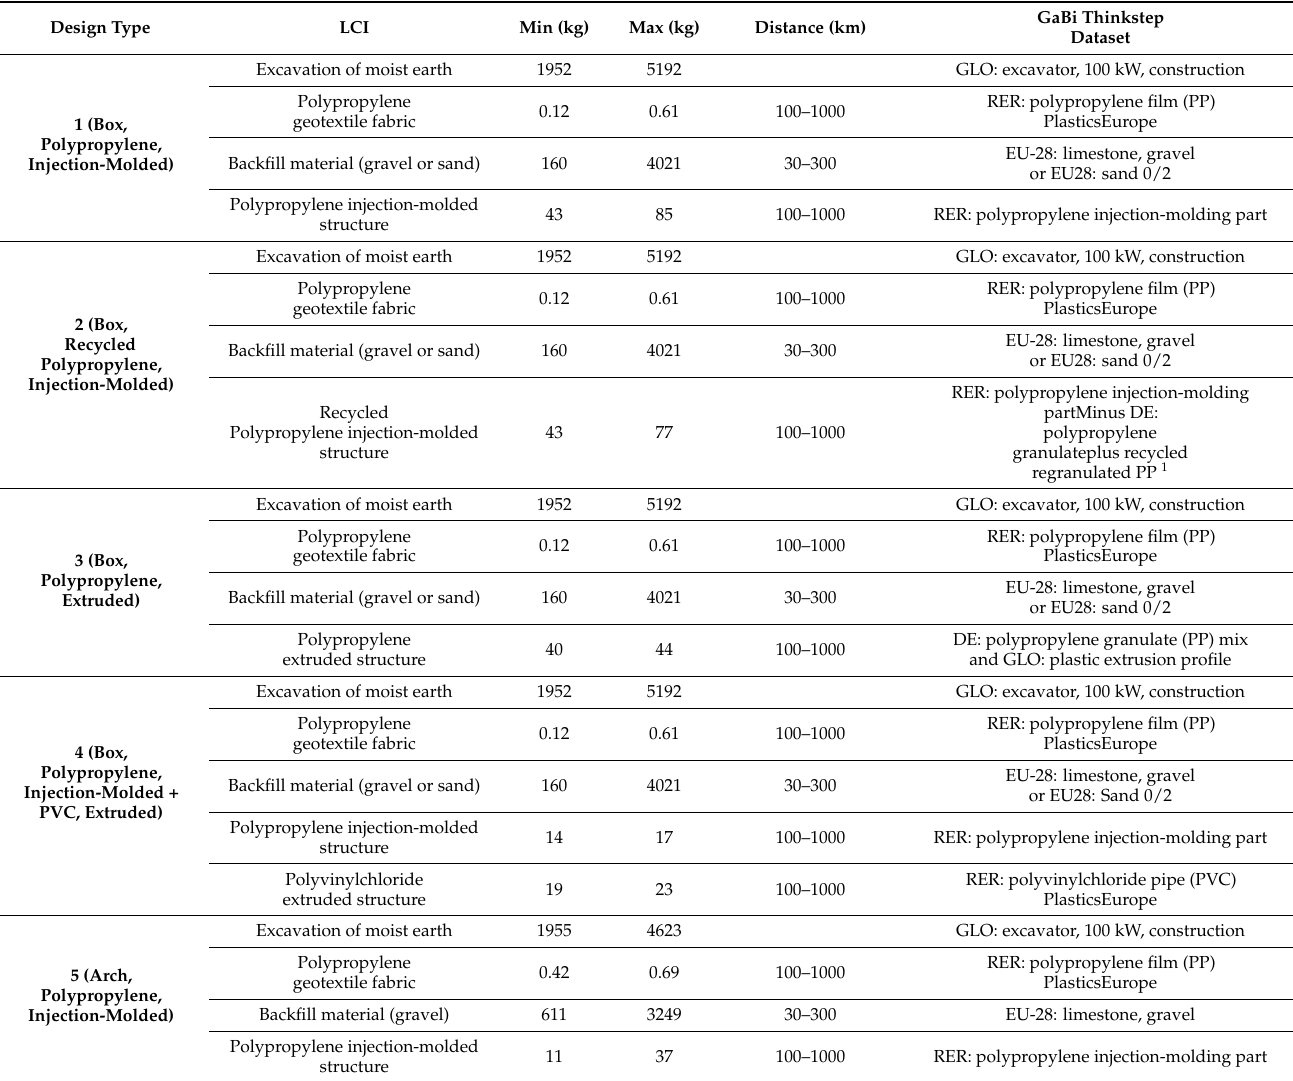
Table 1. Inventories for plastic box and arch installations per cubic meter of stormwater